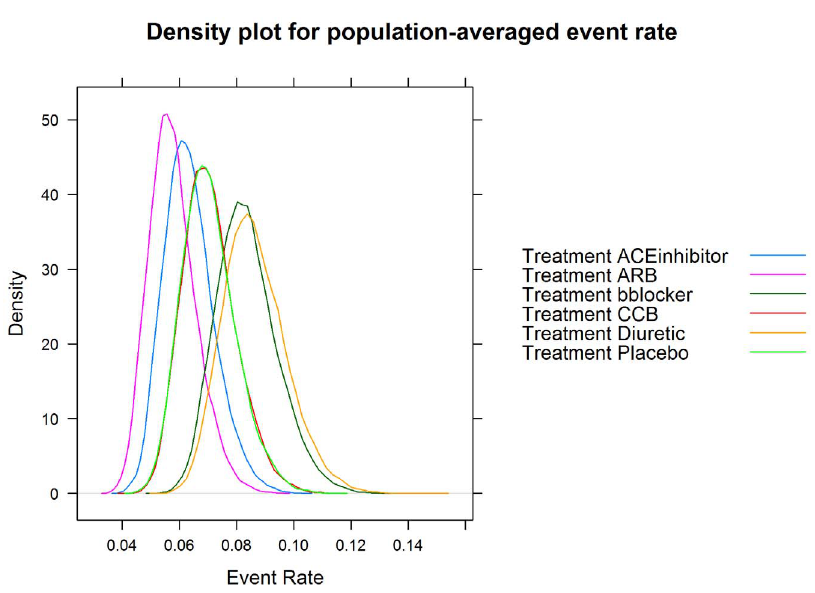
Fig. 7. A density plot from the pcnetmeta R package displaying posterior densities for estimates of the event rates for all treatments in the diabetes